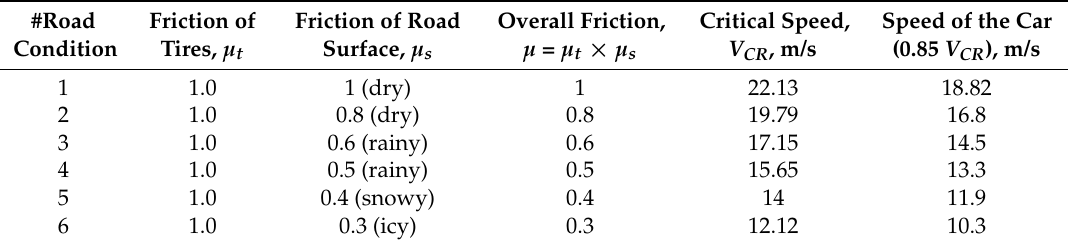
Table 3. Speed of the car during the fitness trial on the test track with different friction